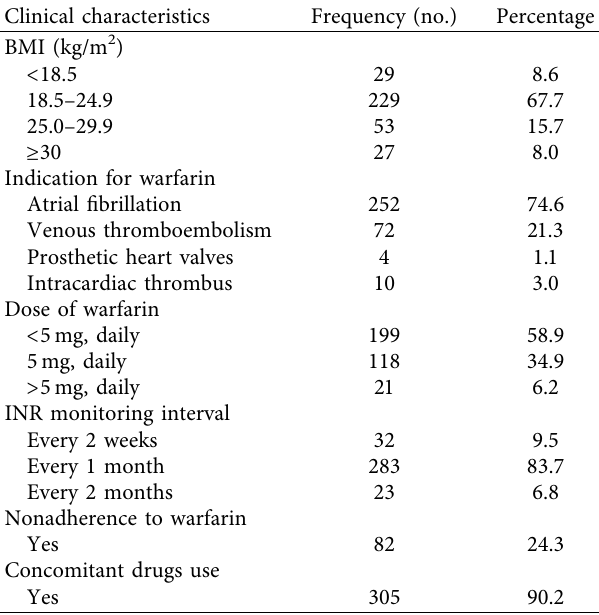
Table 2: Clinical characteristics of patients taking warfarin in University of Gondar hospital, Northwest Ethiopia, from No-